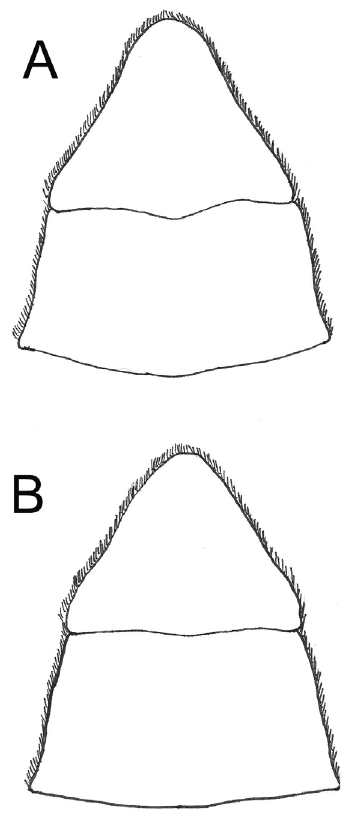
Figure 6. Morphological comparison of somites 5 and 6 between A P. sidneyi (Rathbun, 1904) and B P. danielsi sp.